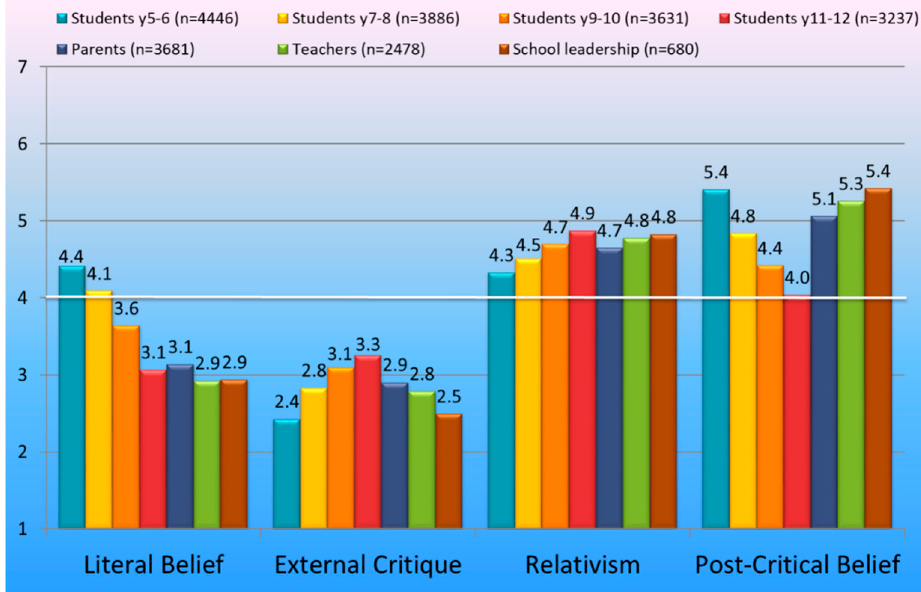
Figure 2. PCB-scale results among all respondent groups in Brisbane.